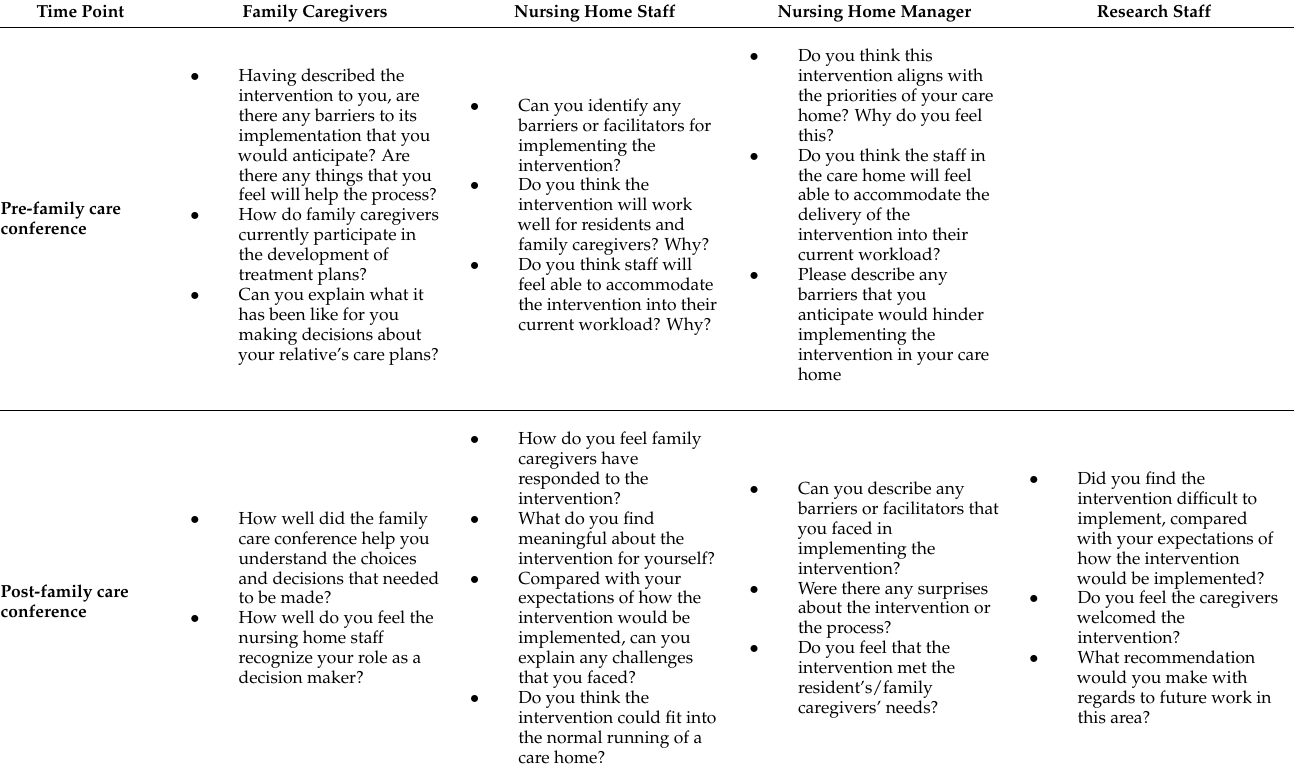
Table 1. Main Interview Questions for Family Caregivers, Nursing Home Staff, the Nursing Home Manager, and the Research Staff According to the Time